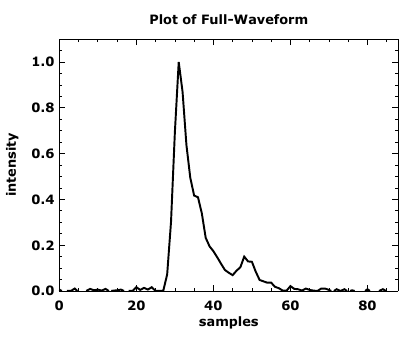
Figure 4. Example for individual full-waveform.